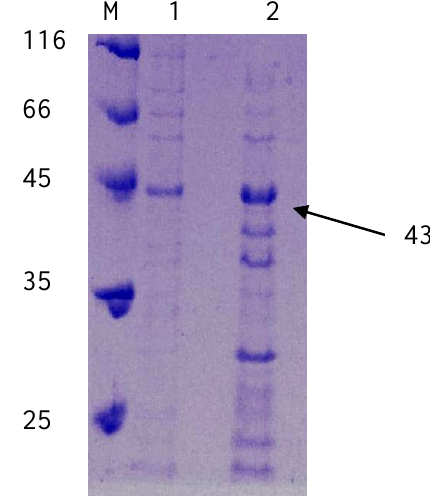
Figure 4. SDS PAGE analysis of AT2 in (1) the absence of 0.6 mM IPTG as inducer; (2) and its presence; (M) Protein molecular weight marker. The expression product was electrophoresed on 12% (w/v) of SDS-PAGE and stained with Coomassie